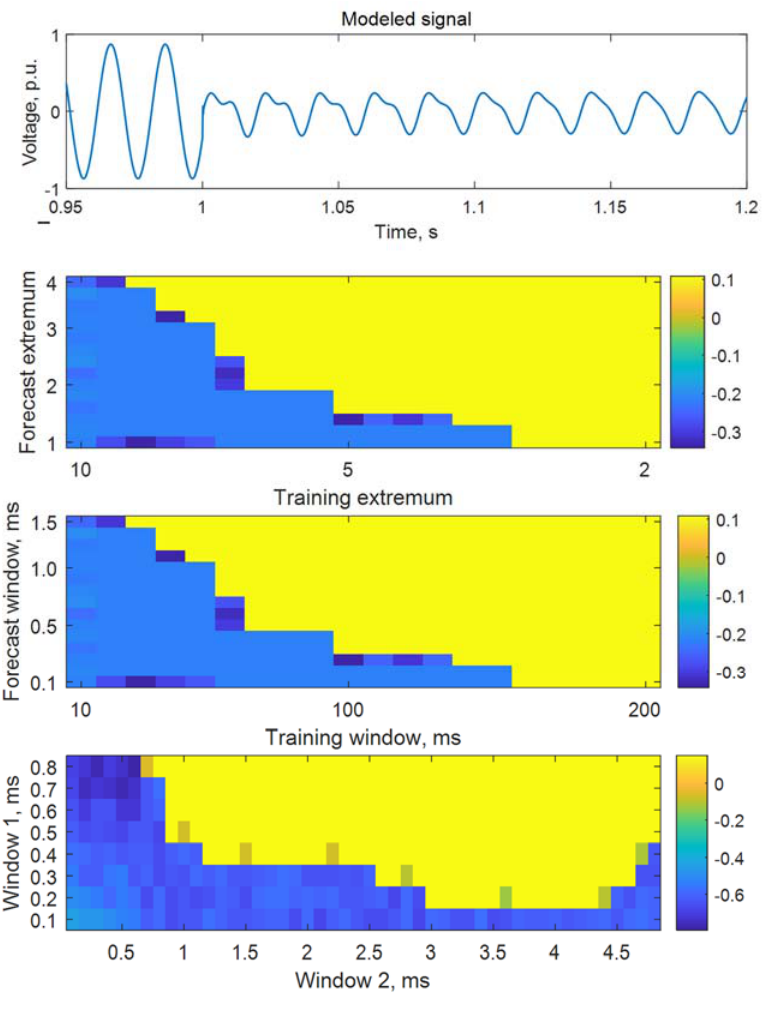
Figure 6. Results of algorithms